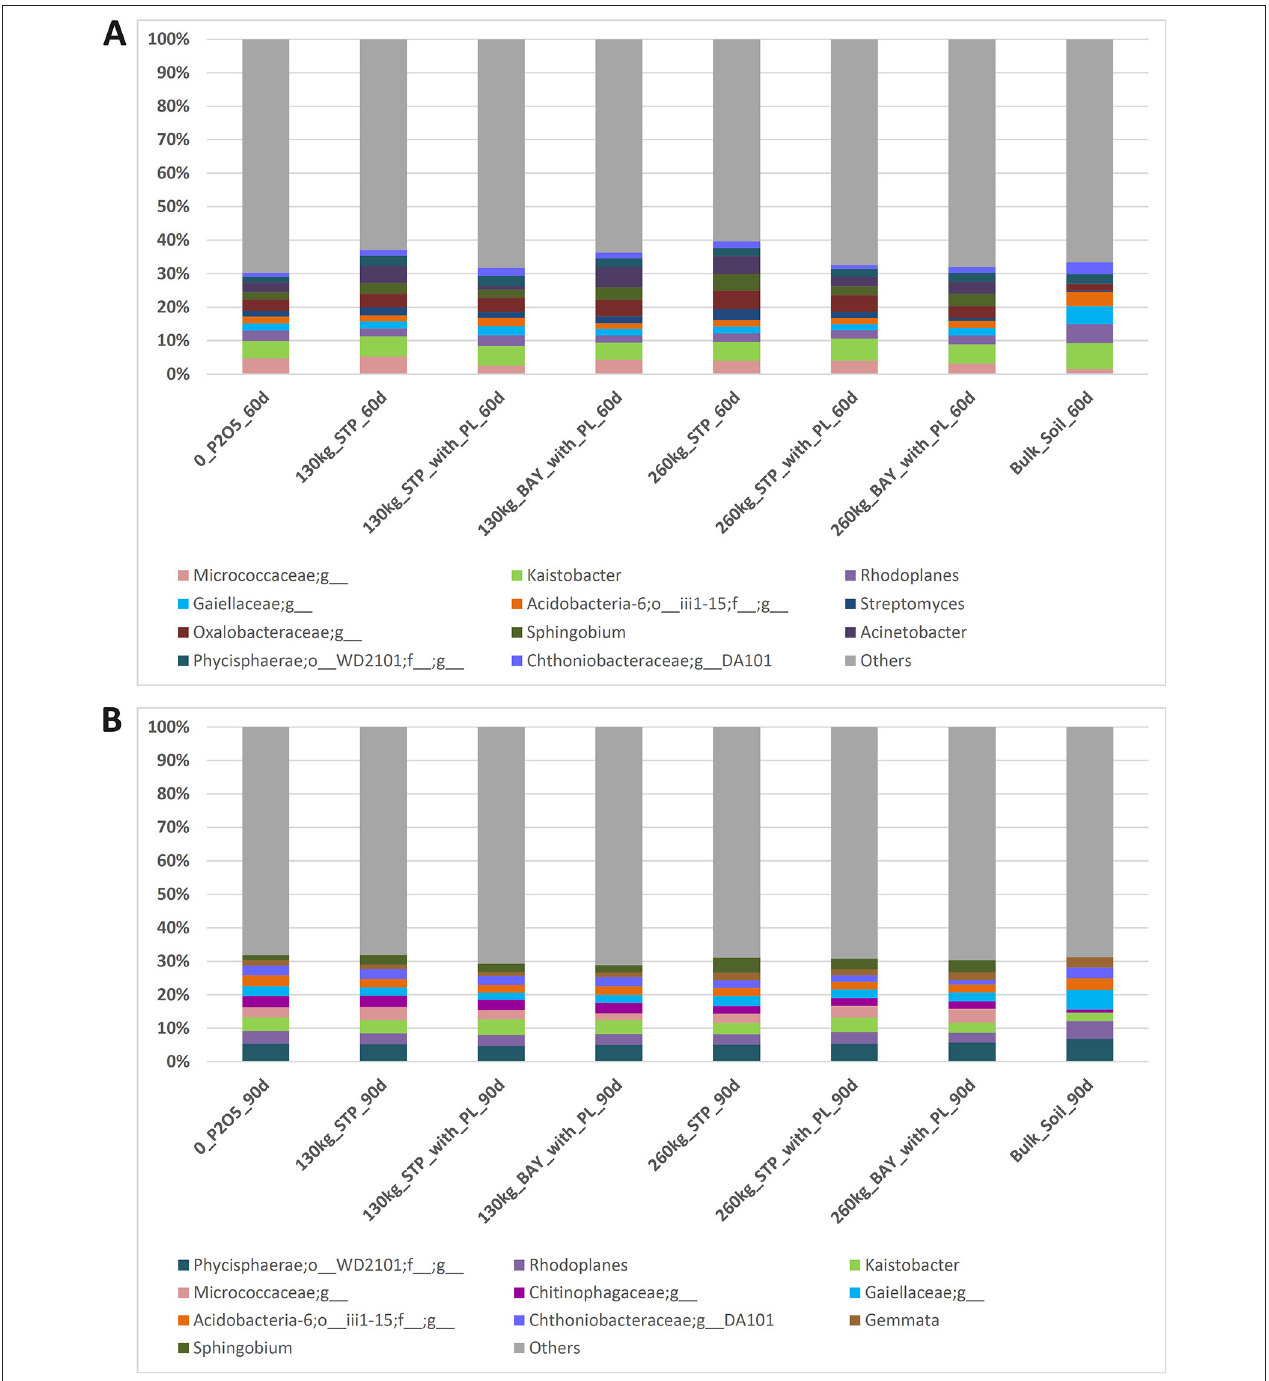
FIGURE 2 | Relative abundances of the most abundant bacterial genera found in maize rhizosphere subjected to different phosphorus fertilizers and in bulk soil, as determined by high-throughput sequencing. (A) Samples taken 60 days after sowing maize, and (B) Samples taken 90 days after sowing maize.